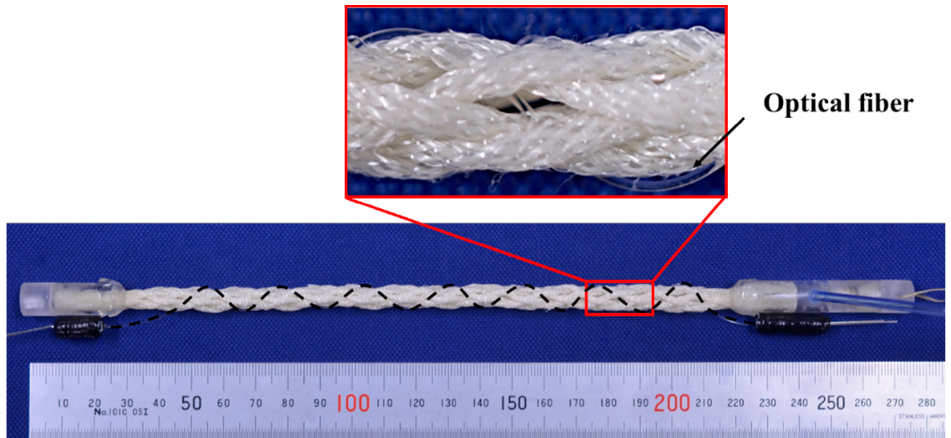
Figure 10. Appearance of the active string actuator that integrates the optical fiber sensor in a wave-like pattern.